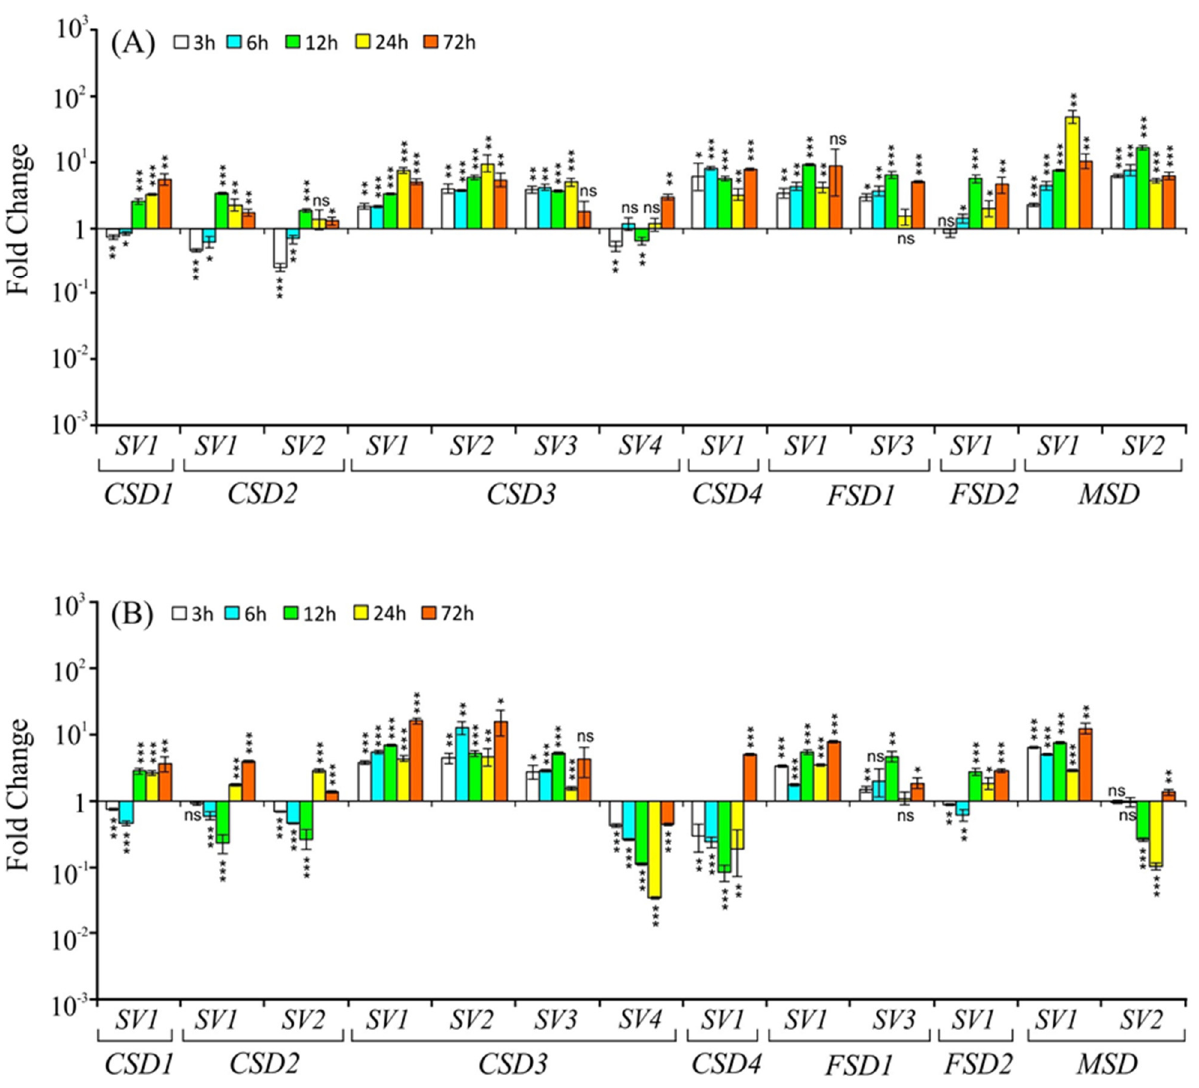
Figure 4. Relative transcript levels (on Y -axis) of CSDs , FSDs , and MSD splice variants (indicated by numbers on X -axis) in response to osmotic stress (15% PEG), in shoot ( A ) and root ( B ) tissue at 3 h, 6 h, 12 h, 24 h, and 72 h after the stress treatment. For normalization and statistical analysis, see figure legend 3.